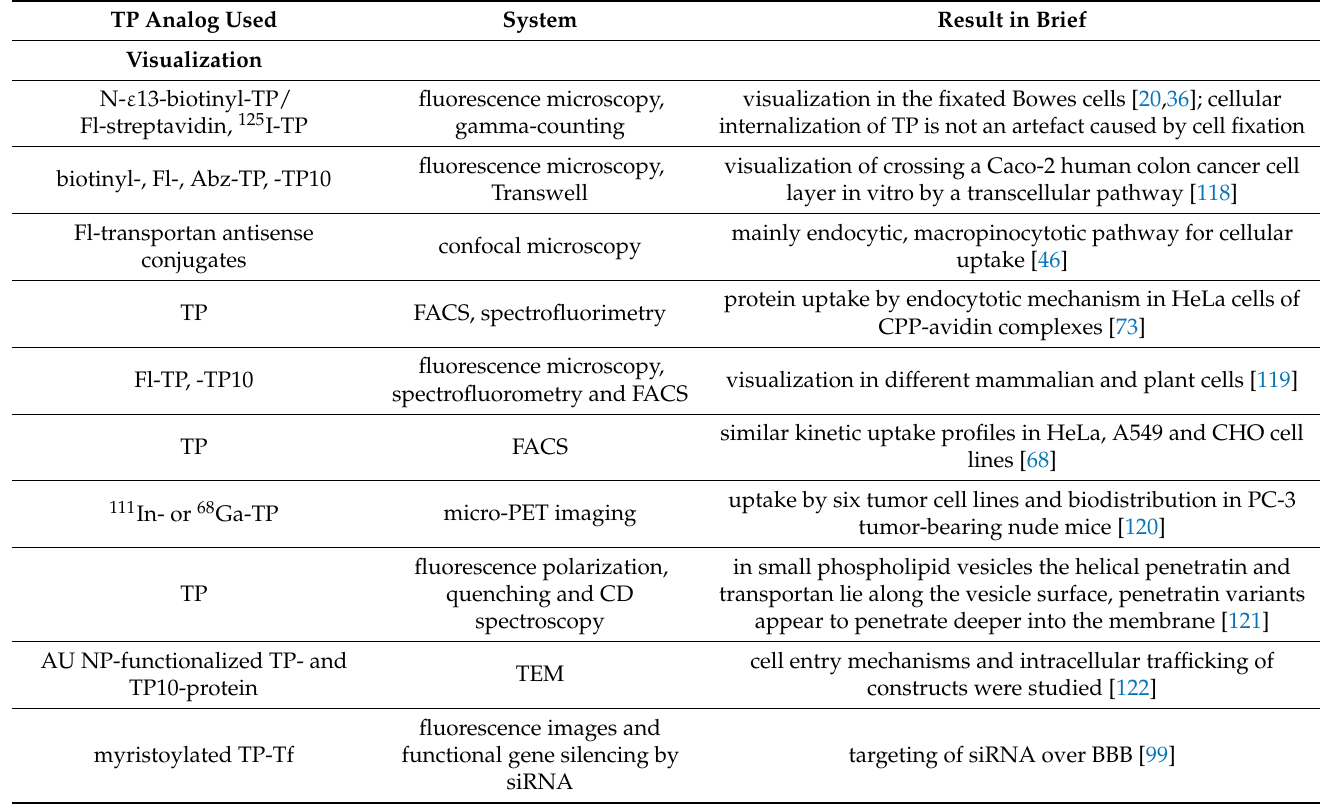
Table 1. Summary of the mechanisms of uptake and toxicity studies of transportans and their conjugates with bioactive cargos; see the details in the